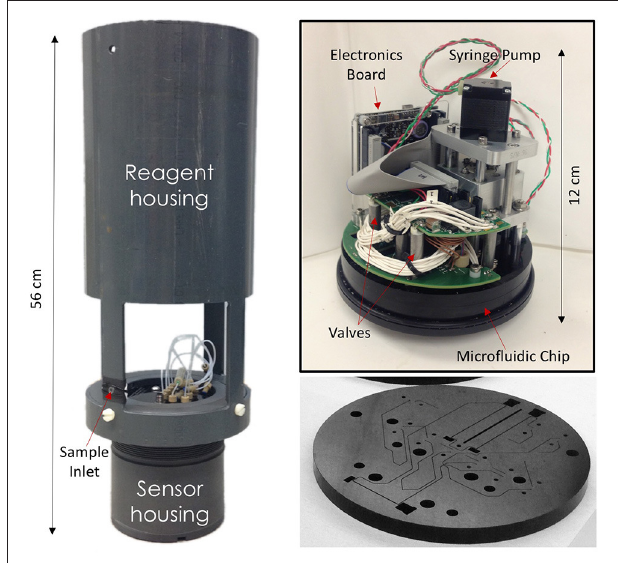
FIGURE 1 | Pictures of the Lab-On-Chip phosphate sensor. (Left) A fully assembled sensor with reagent housing. (Top-right) A LOC sensor prior to placement in the watertight sensor housing. (Bottom) One of the PMMA layers of a phosphate Lab-On-Chip (Sensor 1) showing the micromilled microfluidic channels prior to sealing with the other layers of the microfluidic